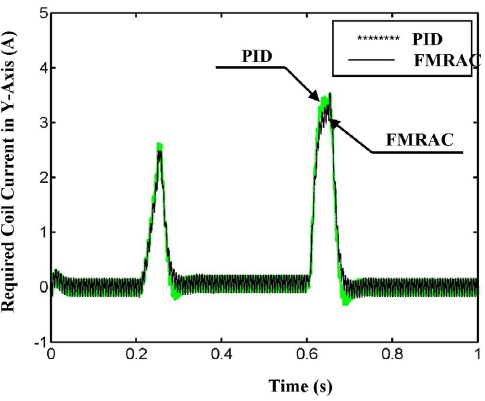
Figure 12. Comparison of required coil current for ECAMA in the Y -axis under various control laws.